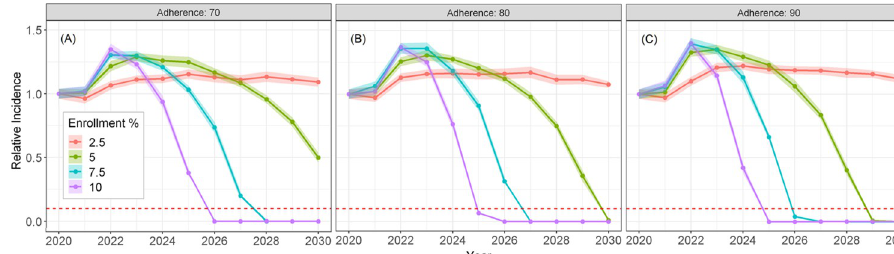
Fig 5. Projected HCV mean incidence of new chronic infections among PWID relative to the predicted 2020 incidence during with no restriction on DAA treatment frequency. Enrollment percent is DAA rate (e.g., enrollment of 10% is treatment of 100 per 1000 PWID per year) and treatment adherence of 70% (A), 80% (B), and 90% (C). The ribbons represent the 95% confidence interval around the mean of 20 simulation runs. The horizontal red dashed line represents the WHO 2030 goal of 90% reduction in the incidence